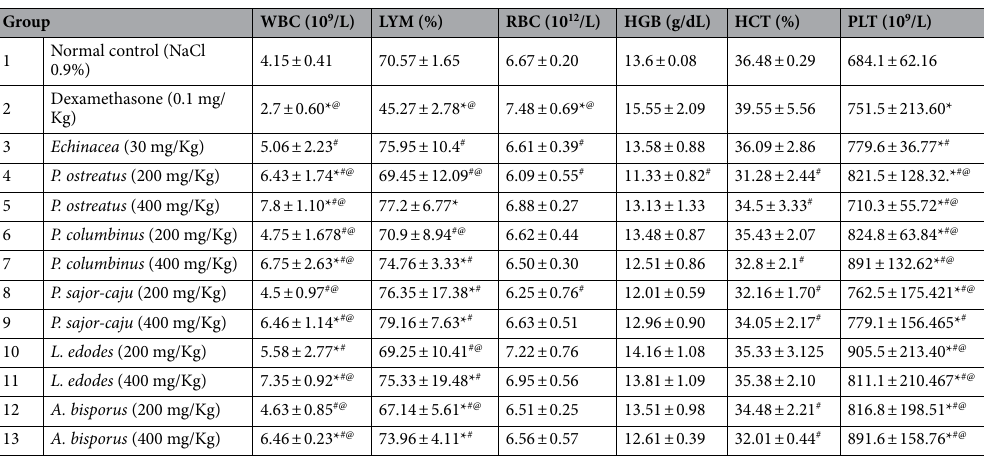
Table 1. Hematologic parameters in rats administered the mushroom extracts as compared to controls. Data are mean ± SD (n = 6). HCT haematocrit, Hb haemoglobin, PLT platelet, RBC red blood cell, WBC white blood cell, LYM Lymphocytes. * Significantly different from normal control group, # significantly different